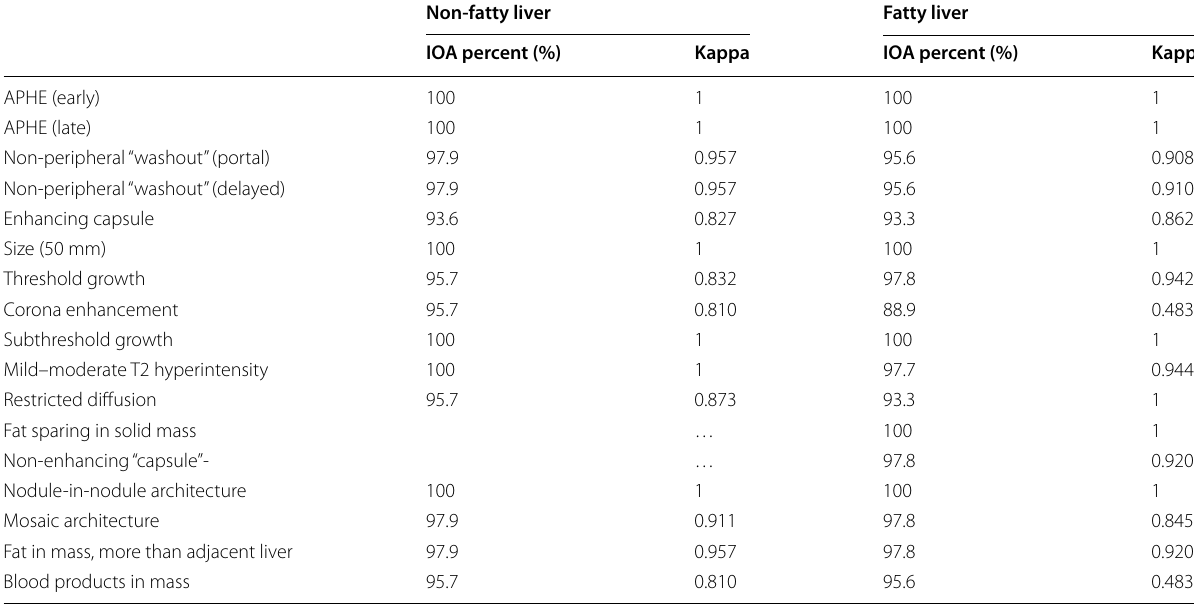
Table 7 Interobserver agreement for HCC features in positive and negative hepatic steatosis patients Non-fatty